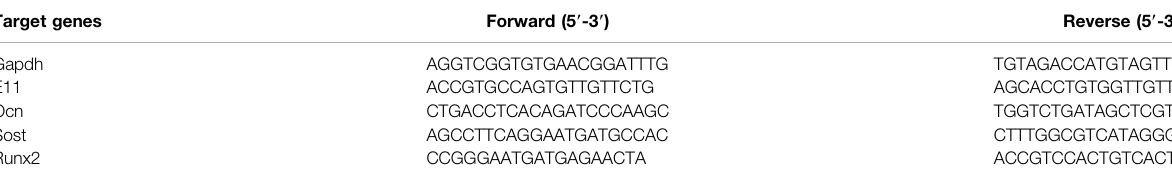
TABLE 1 | Primer sequences for the quantitative reverse-transcription polymerase chain reaction. Target genes